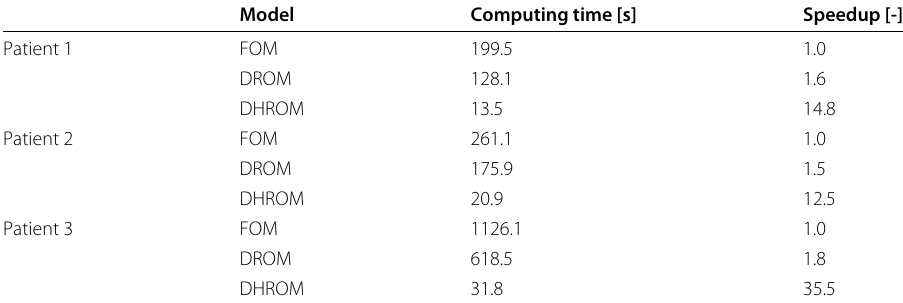
Table 6 Timing for patient-specific models. All computations were performed on 4 cores (Intel Xeon W-2133 (3.60GHz)). The reported timings are mean values of seven simulations (per patient). Speedup is computed using FOM timing as a reference Model Computing time [s]